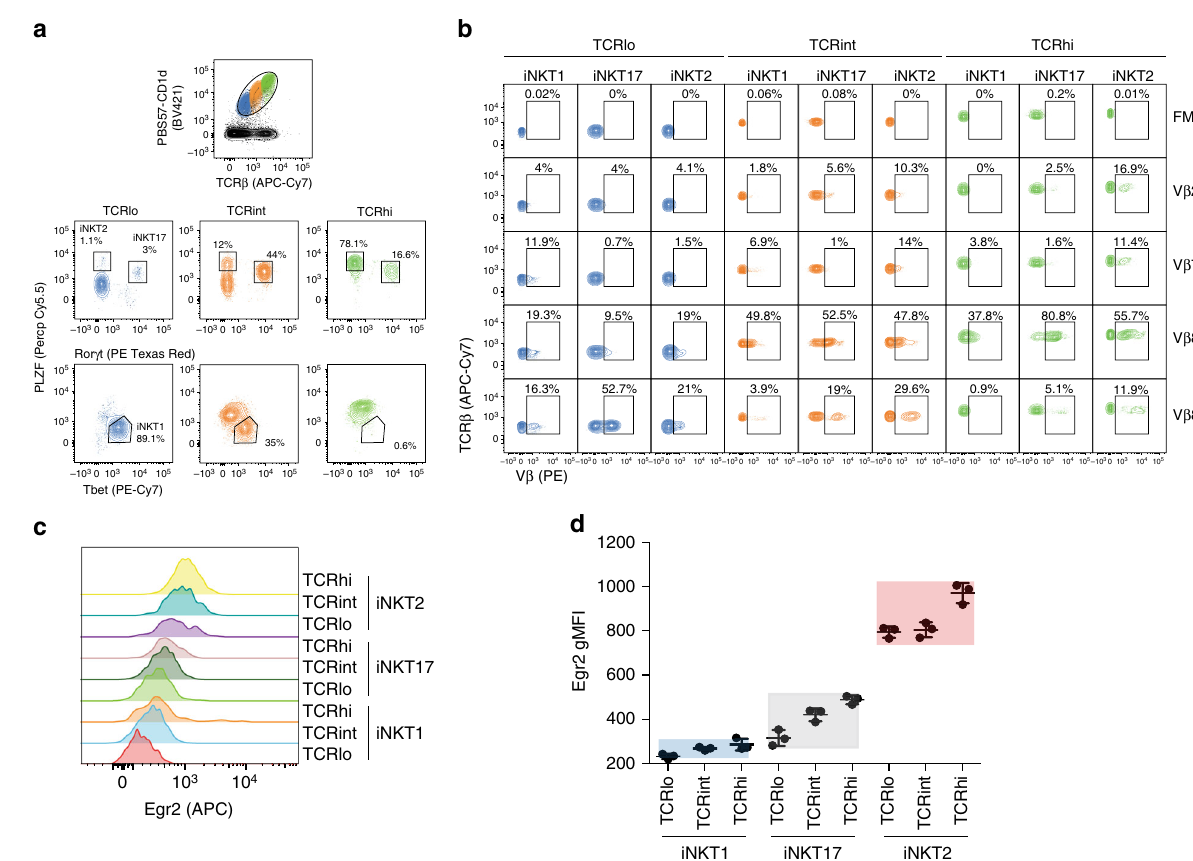
Fig. 3 Thymic iNKT subsets with different TCR levels express different proportions of V β usage but discrete Egr2 levels. Cells from the thymus of 8-week- old BALB/c mice were stained with anti-TCR β mAbs, PBS57 – CD1d tetramers, mAbs speci fi c for the transcription factors PLZF, Ror γ t, and Tbet and the indicated anti-V β mAbs. a iNKT cells were subdivided based on expression of different TCR levels. The proportion of iNKT cell subsets for each level of TCR expression (TCR low (blue), TCR int (orange) and TCR high (green)) is shown. b The percentage of V β usage found in each iNKT subset expressing three distinct TCR levels is shown with the fl uorescence minus one control (FMO). Data are representative of three independent mice analyzed. c Example of Egr2 expression in each iNKT cell subsets expressing different levels of TCR. d The gMFI of Egr2 expression was recorded from three independent staining of iNKT cell subsets expressing different TCR levels from one individual mouse as gated in a . Three independent mice were analyzed in this way with similar that TCR hypo-responsiveness affects iNKT cell development even at the earliest stage of commitment.